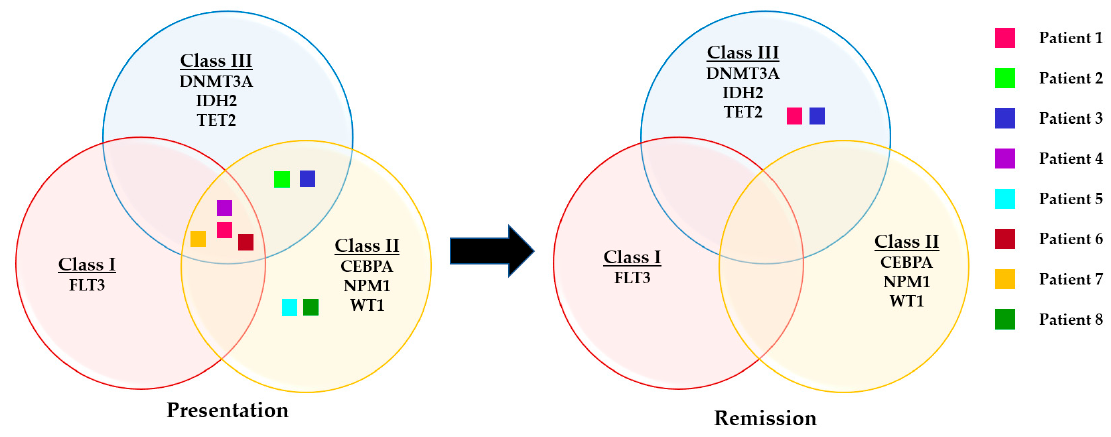
Figure 3. Representation of somatic variants during disease presentation and after attainment of CR1/CR2 based on the mutational classes.